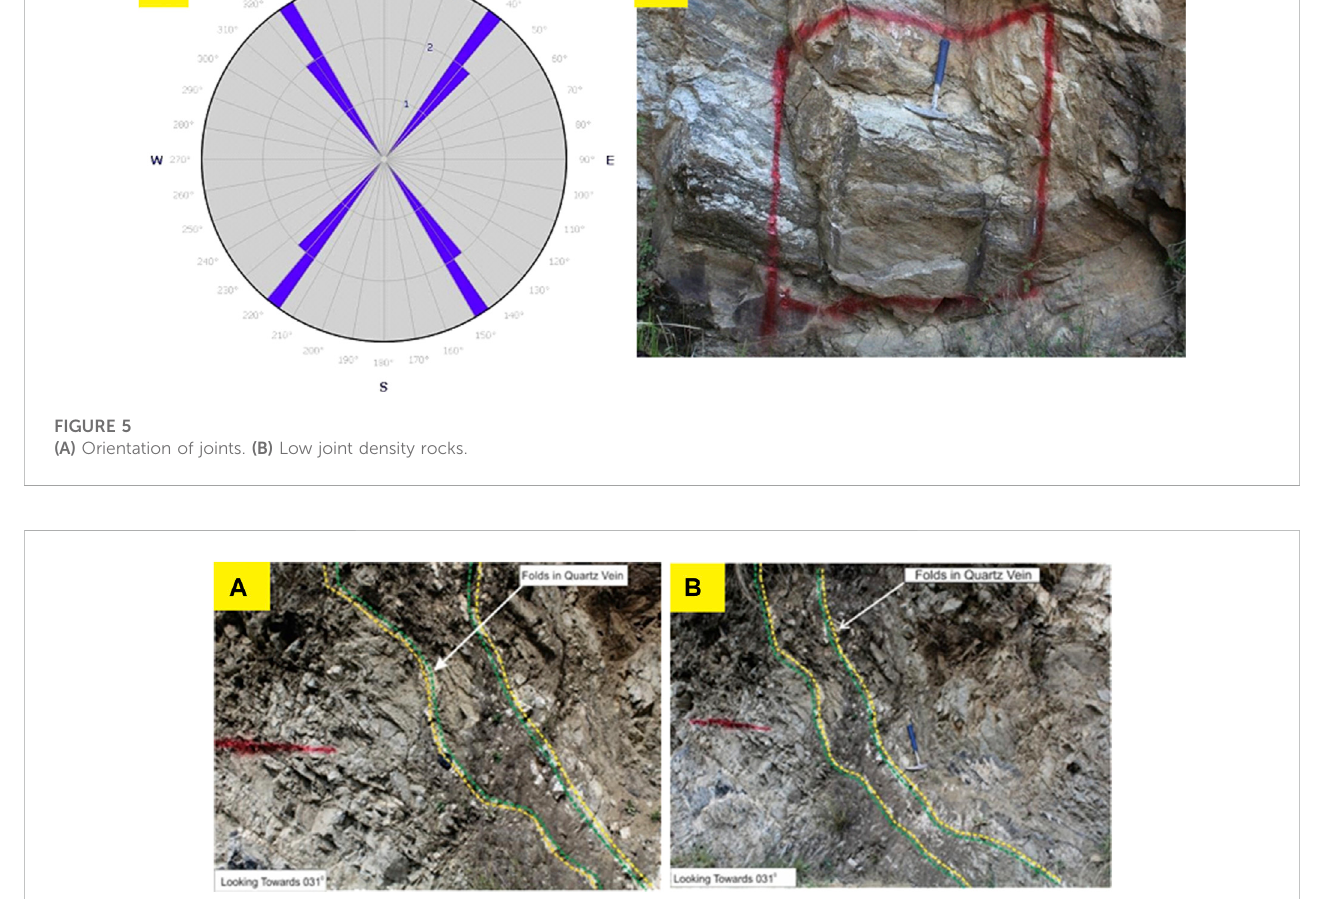
Frontiers in Earth